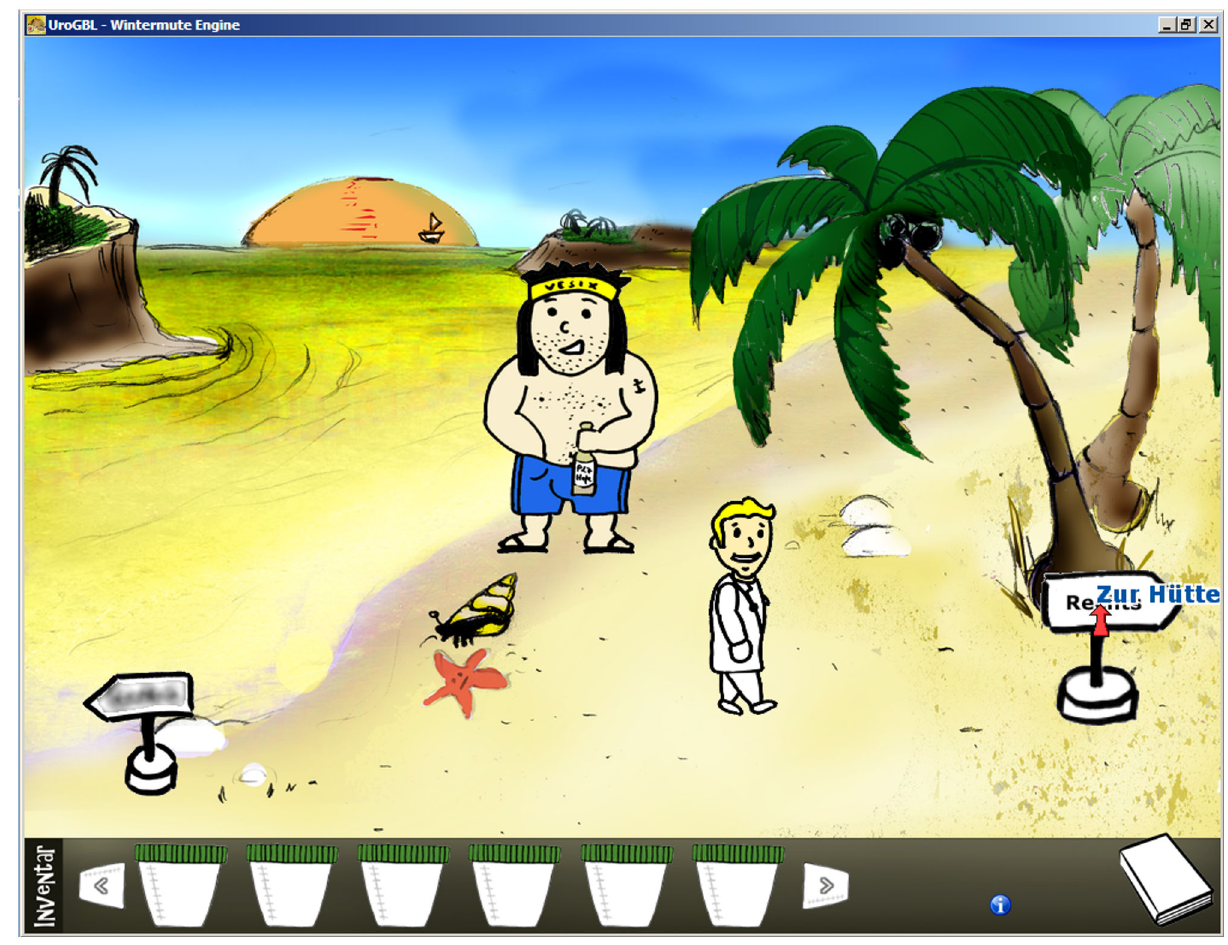
Figure 2. Scene from Uro-Island. The character controlled by the player ("the doctor") exploring the island. He engages in dialogues with the non-player character